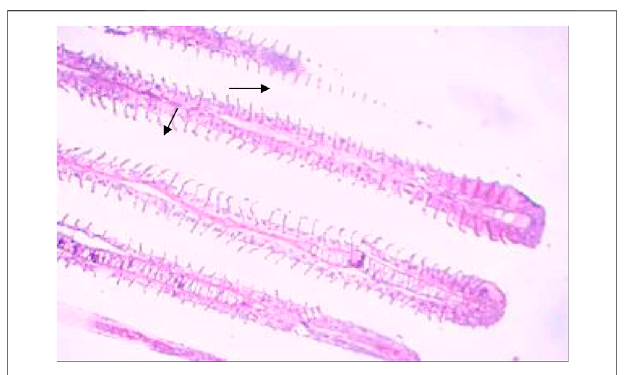
FIGURE 8 | Control muscle showing muscle fi bers.